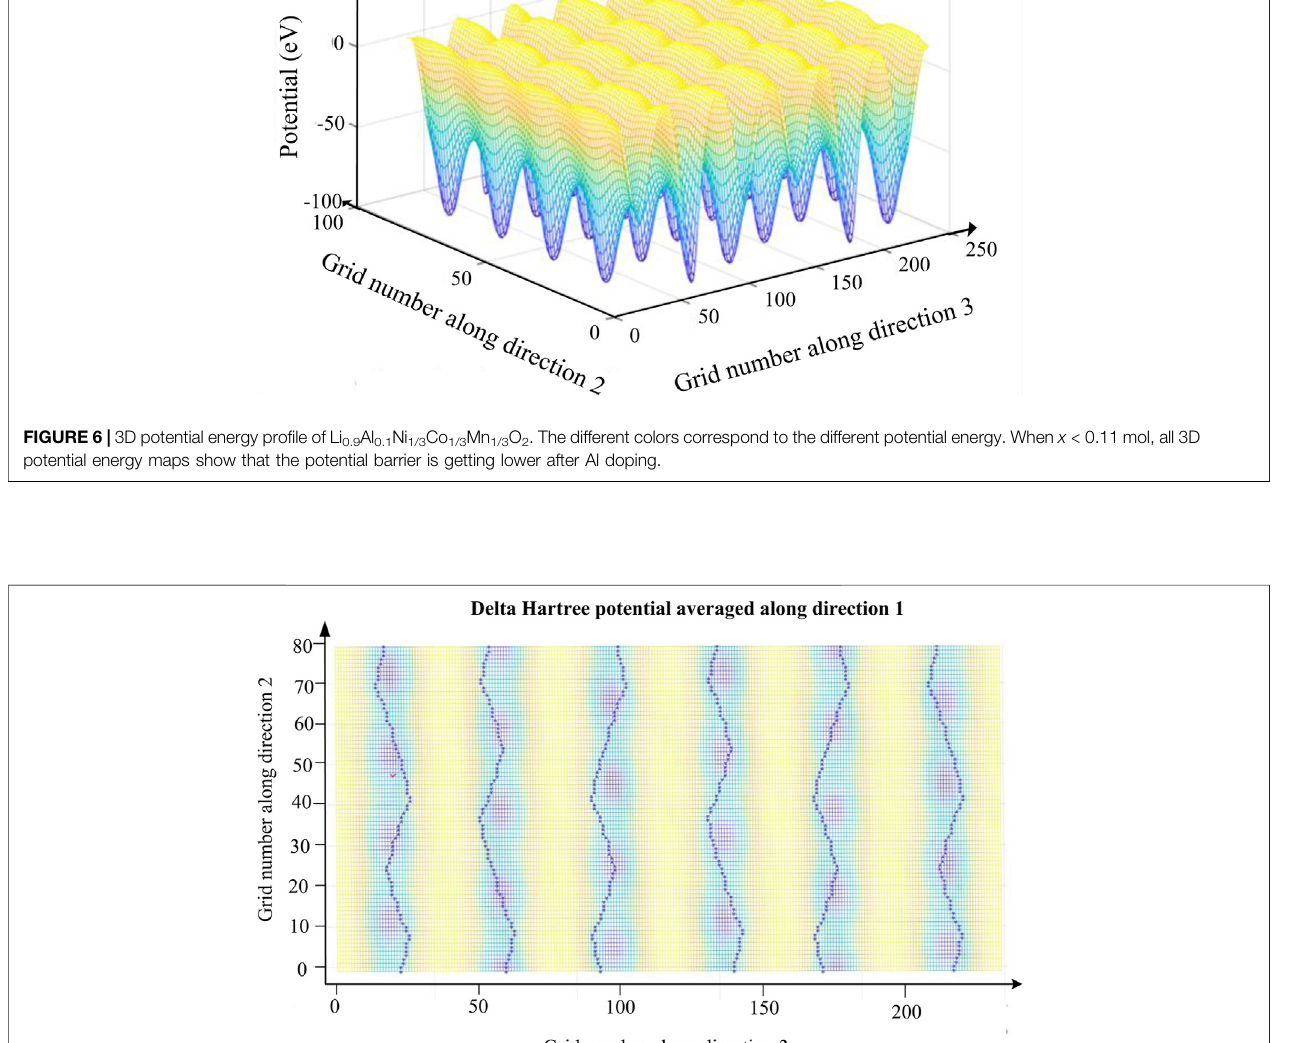
the phase transition during the charging/discharging process.